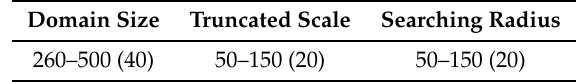
Table 2. Ranges of parameters for generating testing algorithms. Units are in kilometers. The interval of each parameter is displayed in blanks.